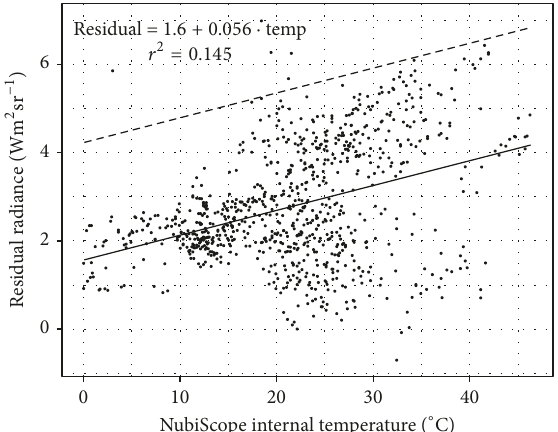
Figure 2: Scatterplot NubiScope internal temperature versus resid- ual radiance (NubiScope measurement minus Streamer modelled spectral radiance) at a zenith angle of 3 ∘ . Solid line represents linear regression model of all points taken into account, dashed line is regression line plus two standard deviations of the residual radiance, and formula and 𝑟 2 belong to the regression model. Figure 3: Scheme of a single measurement, (a) lateral view, (b) top view, 𝑎 𝑖 and 𝑏 𝑖 = variables concerning ellipse major and minor axis, respectively, 𝑑 𝑖 = variables concerning distance of ellipse centre point from NubiScope, 𝛼 = viewing zenith angle, 𝛽 = viewing azimuth angle, 𝜑 = FOV, Ns = position NubiScope, 𝑃 1 = apparent ellipse centre point, and 𝑃 2 = real ellipse centre